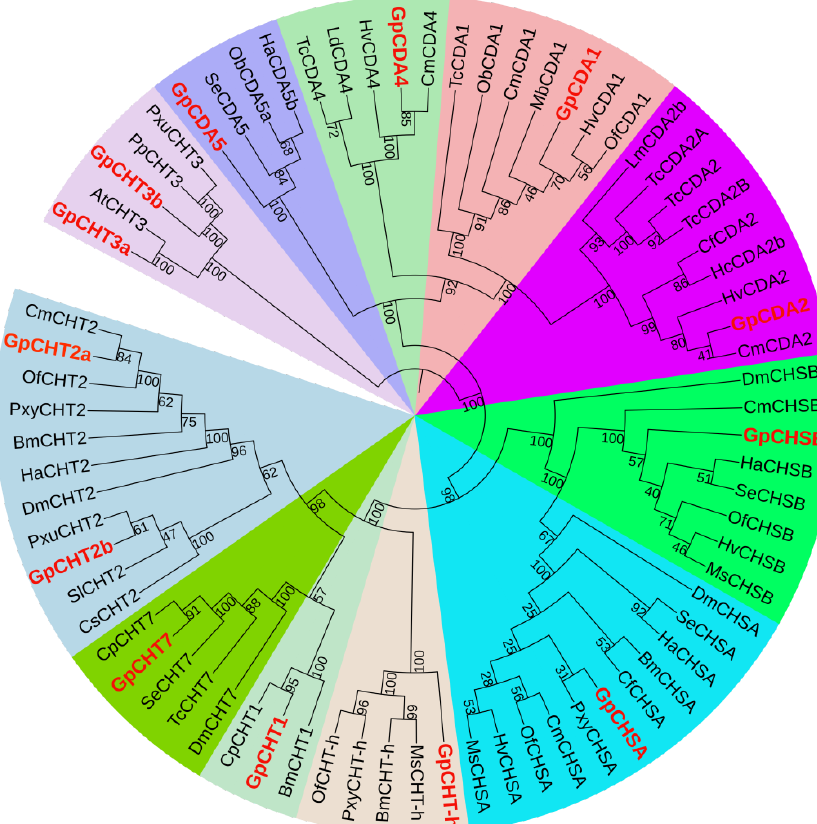
Figure 3. The neighbor-joining tree of chitin metabolism-related enzymes deduced from the coding sequence (CDS) between G. pyloalis and other insect species. The tree was generated from multiple alignments using MEGA 6.0 software. The percentages on the branches indicate bootstrap values from 1000 replicates. Chitin metabolism-related enzymes of G. pyloalis are indicated in red. Ostrinia furnacalis ( Of ), Cnaphalocrocis medinalis ( Cm ), Spodoptera exigua ( Se ), Helicoverpa armigera ( Ha ), Choristoneura fumiferana ( Cf ), Plutella xylostella ( Pxy ), Heortia vitessoides ( Hv ), Bombyx mori ( Bm ), Drosophila melanogaster ( Dm ), Manduca sexta ( Ms ), Operophtera brumata ( Ob ), Hyphantria cunea ( Hc ), Locusta migratoria ( Lm ), Tribolium castaneum ( Tc ), Mamestra brassicae ( Mb ), Leptinotarsa decemlineata ( Ld ), Conogethes punctiferalis ( Cp ), Spodoptera litura ( Sl ), Papilio xuthus ( Pxu ), Chilo suppressalis ( Cs ), Papilio polytes ( Pp ), and Amyelois transitella ( At ).